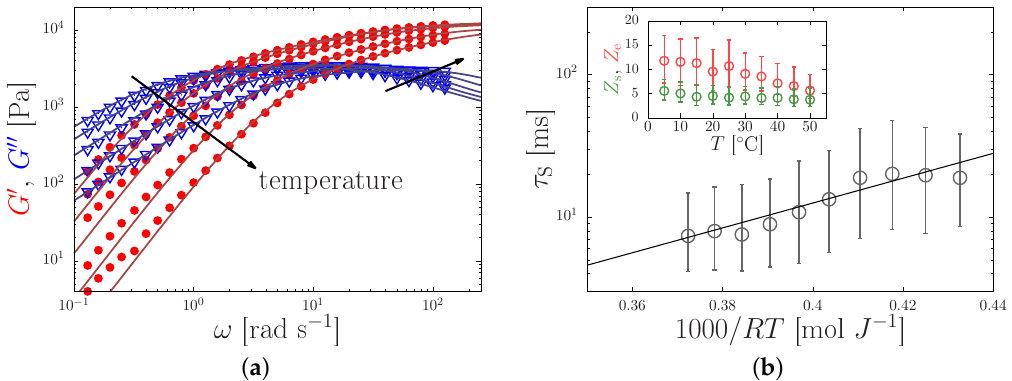
Figure 4. ( a ) Elastic G (cid:48) ( ω ) (dots) and viscous G (cid:48)(cid:48) ( ω ) (triangles) modulus of a silk feedstock with a zero-shear viscosity η 0 = 2554 Pa s at room temperature against the oscillation frequency, ω , for temperatures in the range of 2–50 ◦ C. The sticky- reptation model (lines) was curve fitted to the experimental data (symbols). ( b ) Temperature-dependent sticker lifetime τ s (main panel), and the number of stickers Z s (green) and entanglements Z e (red) per chain (inset) as obtained from the fit in the left panel. By curve-fitting the Arrhenius equation to τ s (solid line) an apparent activation energy E act = 20.1 was found. Both panels are reprinted from Ref. [13] with the permission of the American Chemical